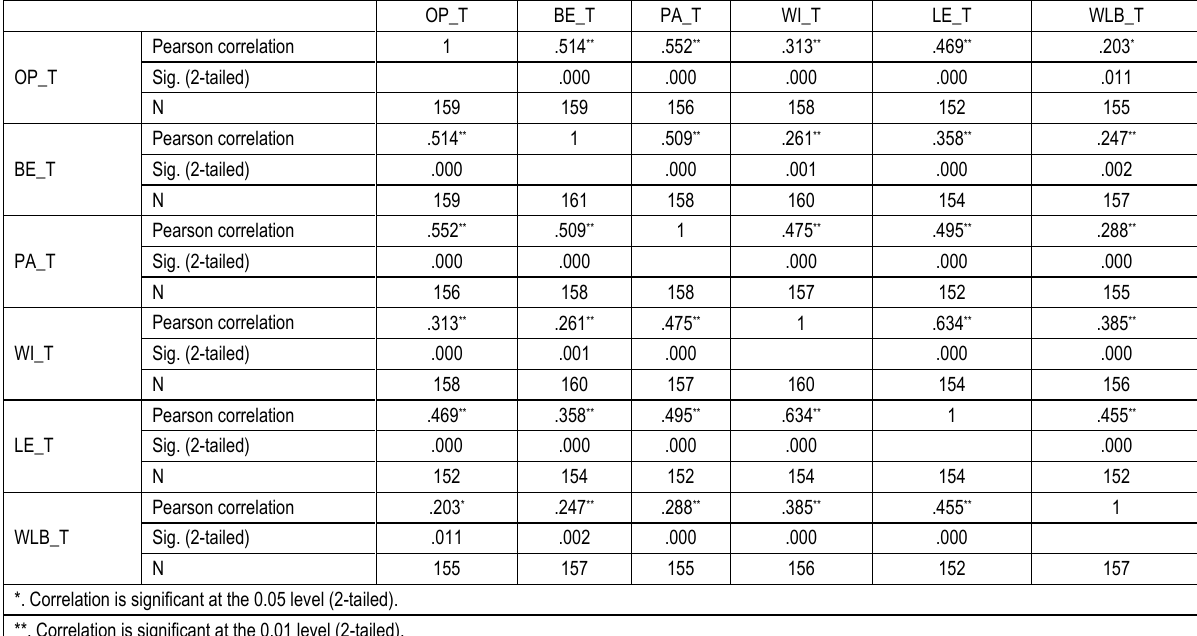
Table 4. Correlation not involving